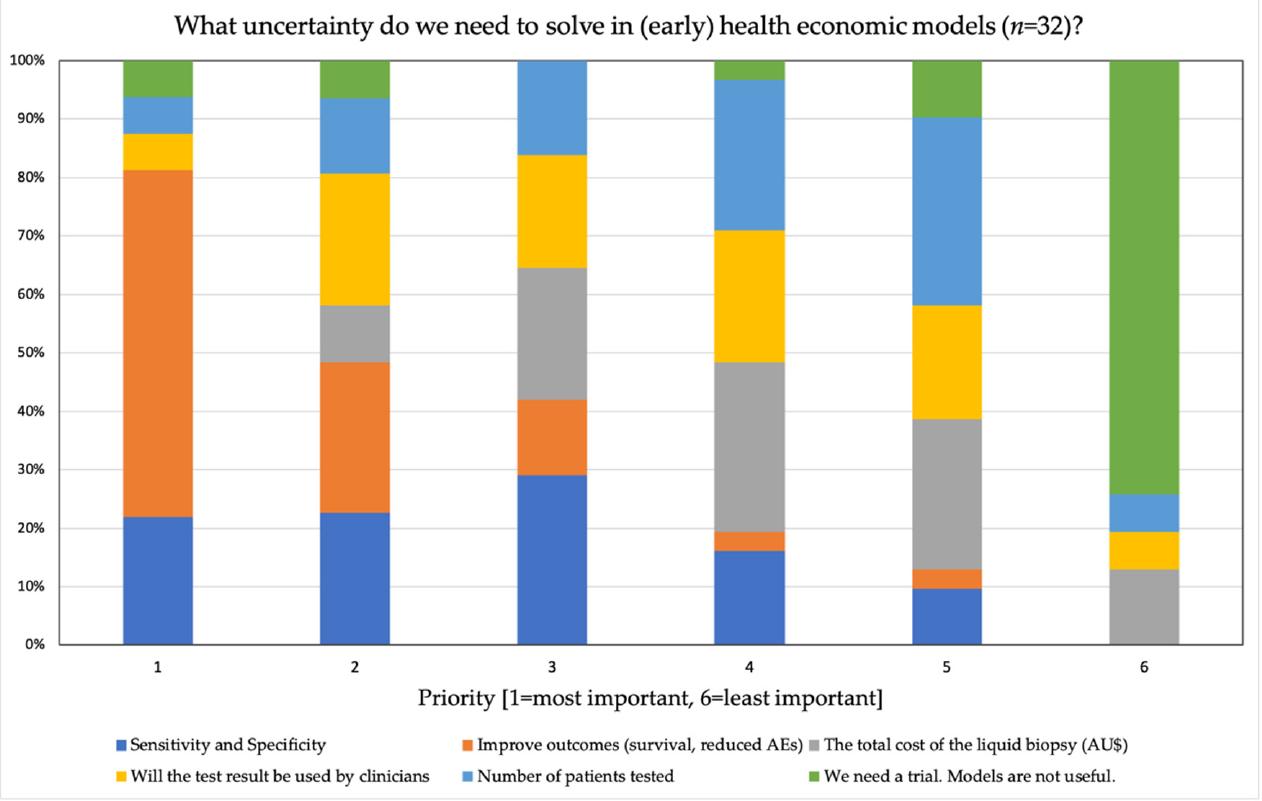
Figure 4. Ranking of statements relevant for health economic modeling of liquid biopsies.